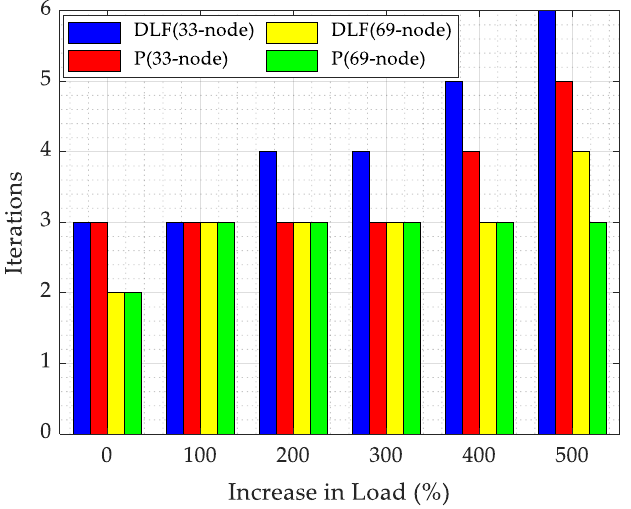
Figure 11. Number of iterations required (proposed versus DLF).